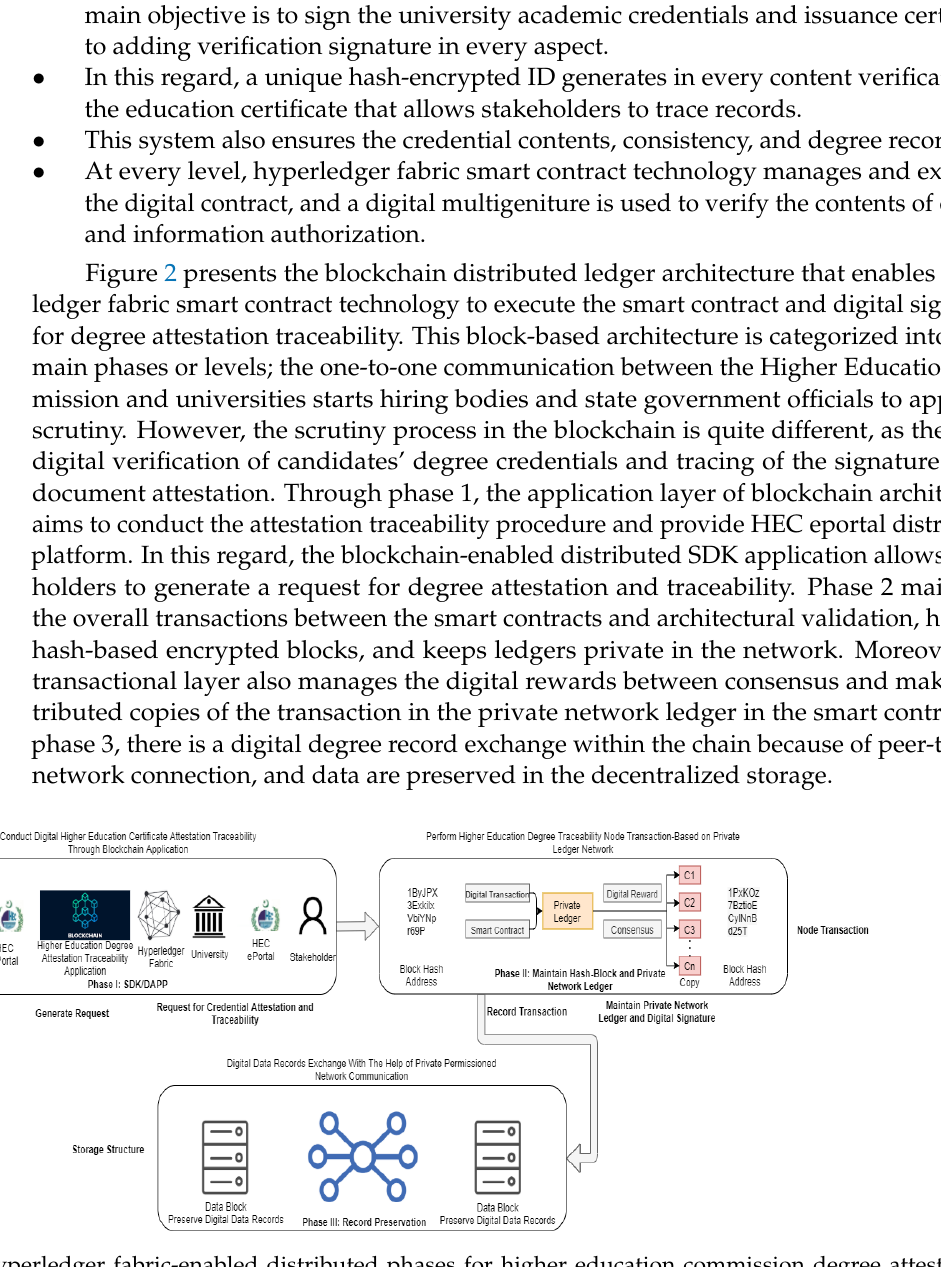
Figure 2. Blockchain hyperledger fabric-enabled distributed phases for higher education commission degree attestation traceability.